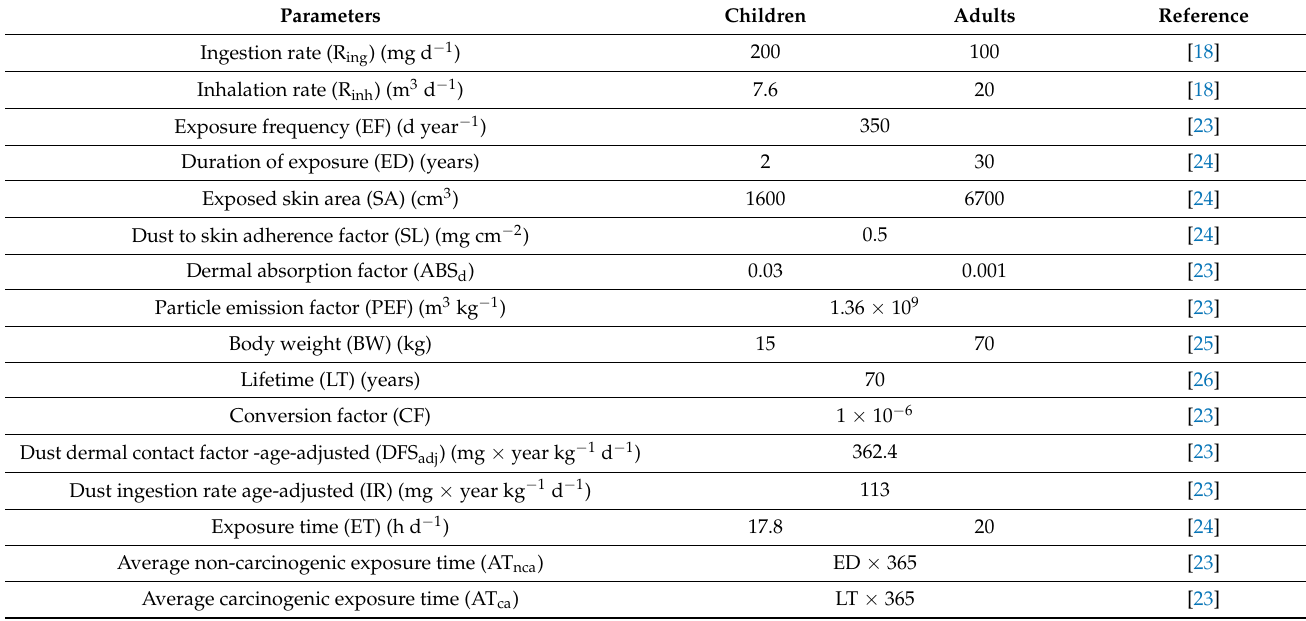
Table 1. Parameters used in human risk assessment